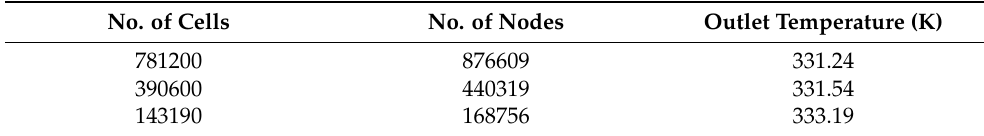
Table 2. Mesh independency check for the evacuated PVT